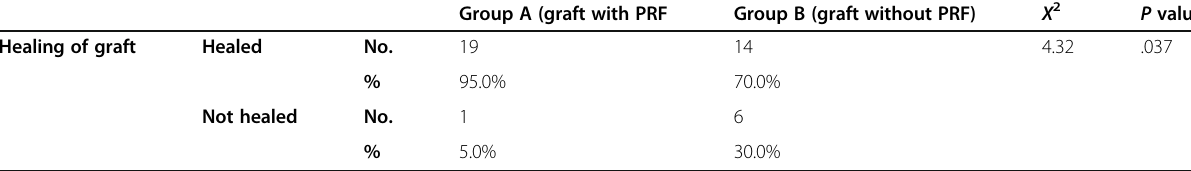
Table 3 Comparison between group A and group B regarding the healing of the graft Group A (graft with PRF Group B (graft without PRF) X 2 P value Healing of